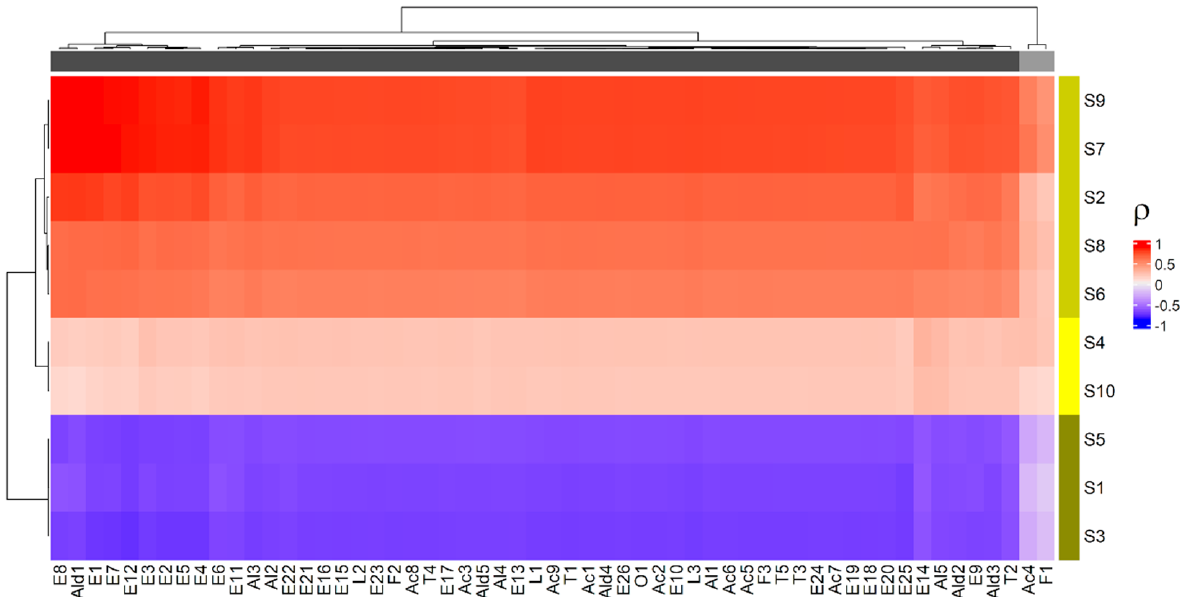
Figure 1. PCA model of the e-nose data: circles represent the observations (technical replicates), while triangles indicate the medians of the technical replicates of the same sample; the green colour is used for observations belonging to the half-red group and the red colour for those of the red group.